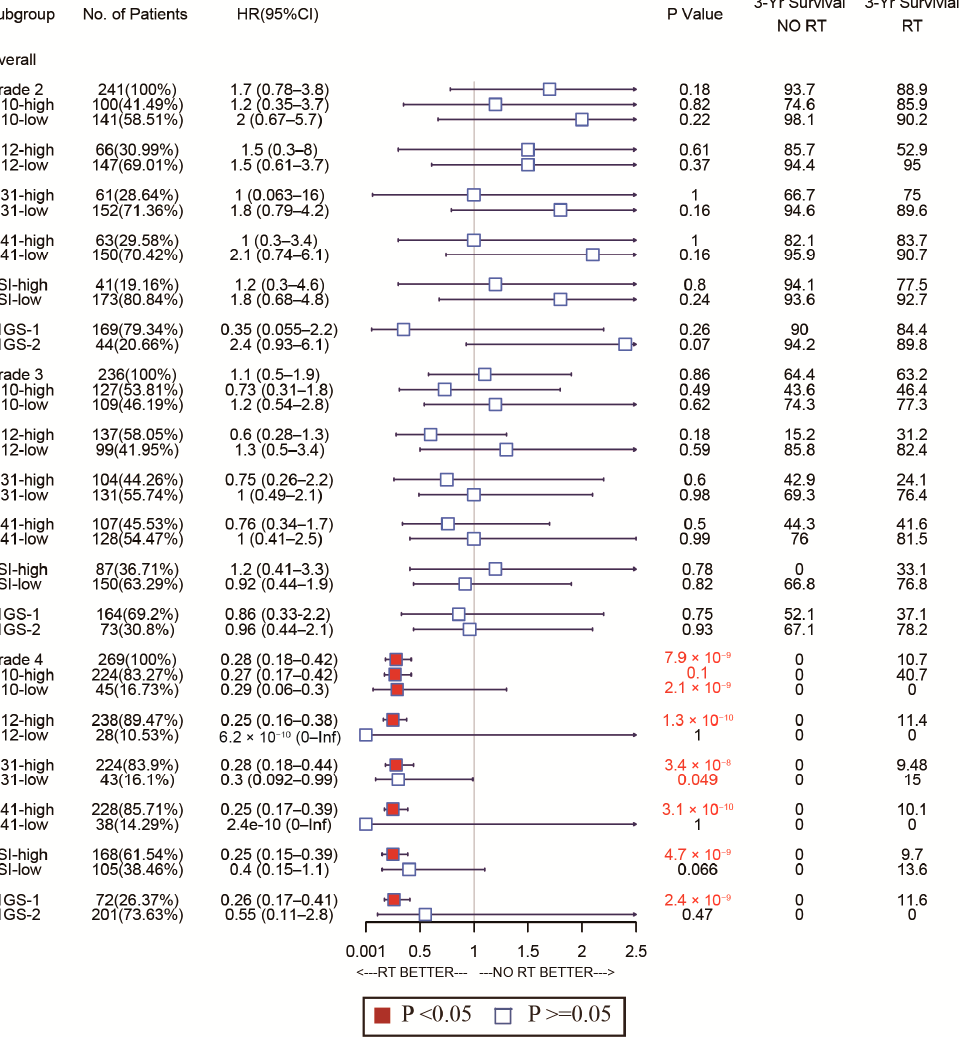
Figure 10. Forest plots to test the sensitivity of the selected markers for different WHO stages in the TCGA cohort.